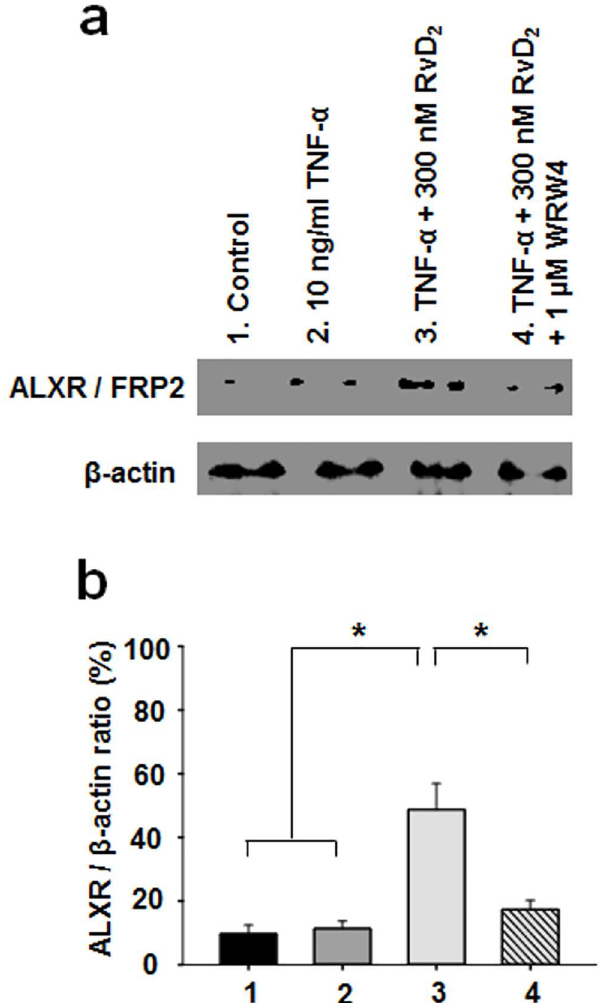
Fig 3. Pharmacological effectsof RvD 2 on ALX / FRP2 protein expression in TNF- α -pretreated human bronchi. a. Human bronchial homogenates derived from control (untreated)bronchi or pre-treatedwith 10